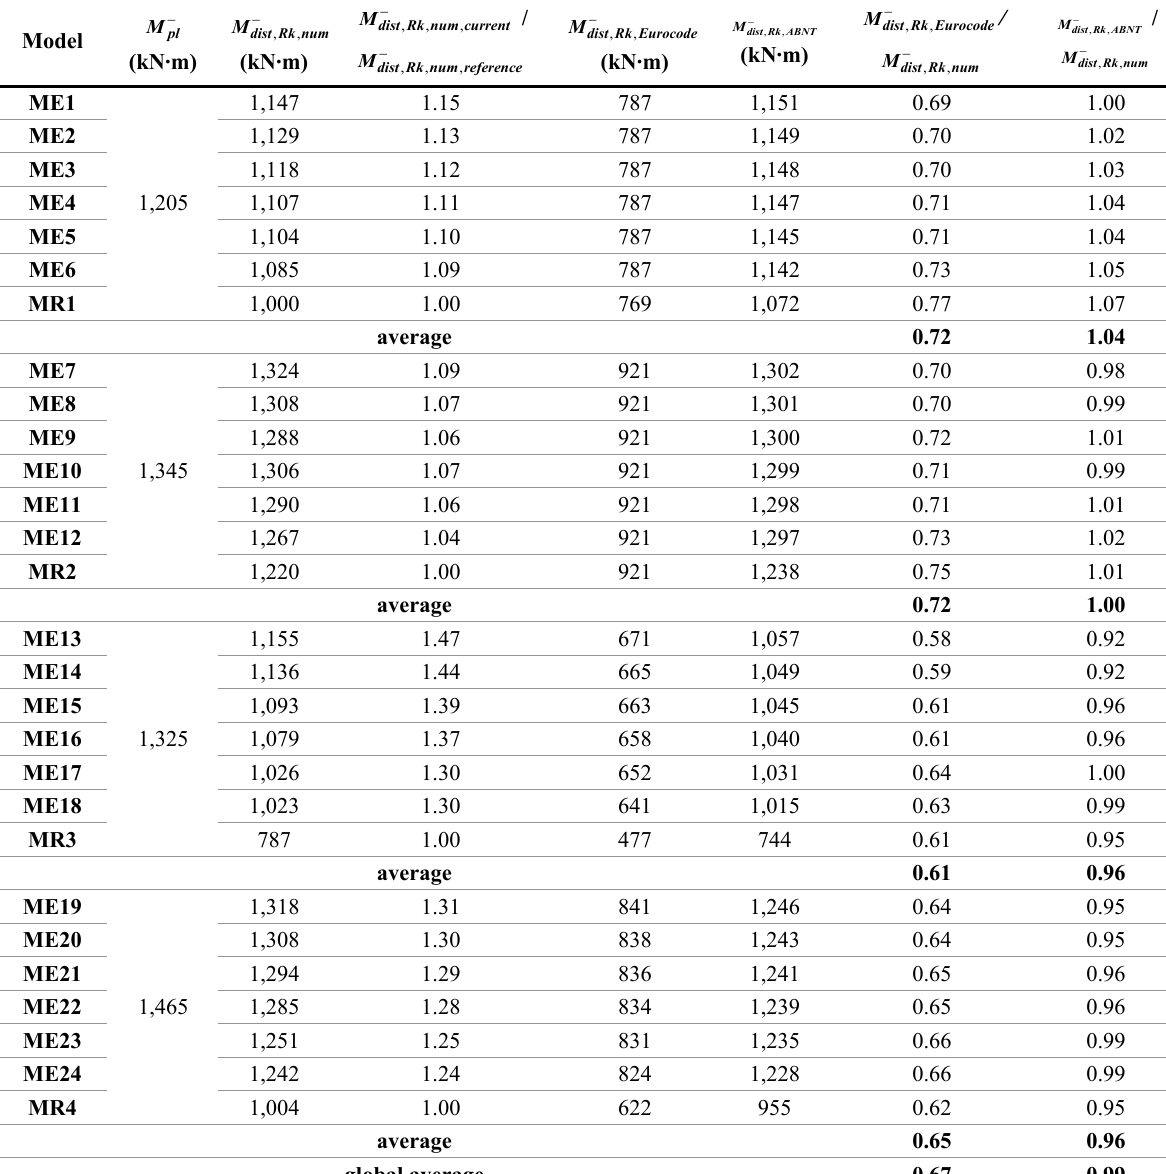
Table 4. Results obtained for the analysis of the transverse stiffeners influence.